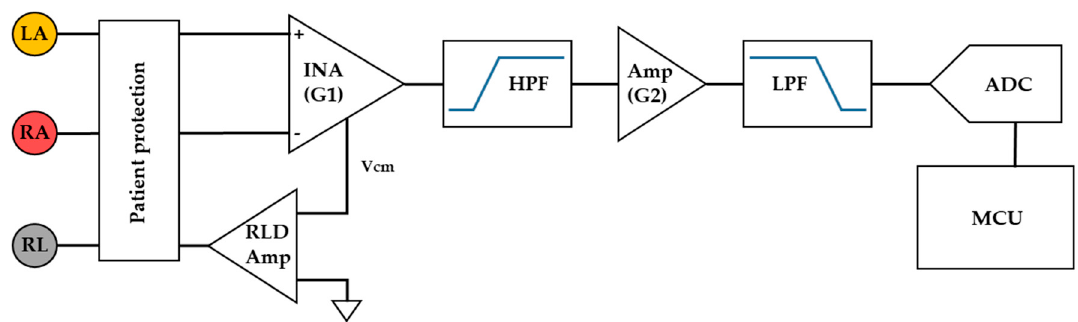
( b ) Figure 2. Arm-ECG sensor: ( a ) top and bottom views of the sintered Ag–AgCl electrodes disks used in the system; ( b ) electrode positions on the left upper-arm. The position of the electrodes was selected considering the results we reported from our previous works [4,5]. According to these studies, the most convenient anatomical location for a bipolar arm-ECG recording lead is using a transversally disposed electrode pair at the upper arm, as shown in Figure 2b. In this way, the arm-ECG signal can be recorded with sufficient amplitude and tolerable noise levels for reliable QRS complex detection and waveform features extraction, as well as heart rate and possible standard ECG Lead I estimation and reconstruction from the bipolar arm-ECG lead [15]. 2.1.2. Front-End ECG Amplifier Configuration A typical ECG signal acquisition system contains several chained stages of amplification and filtering blocks (see Figure 3). First, an instrumentation amplifier (INA) receives the differential signals captured by the sensing electrodes, through a patient-protection circuit block. This stage often provides low amplification (G1) and it is followed by a high-pass filtering amplifier block (HPF) and a second amplifier stage (G2). Finally, a low-pass filter (LPF) reduces the signal